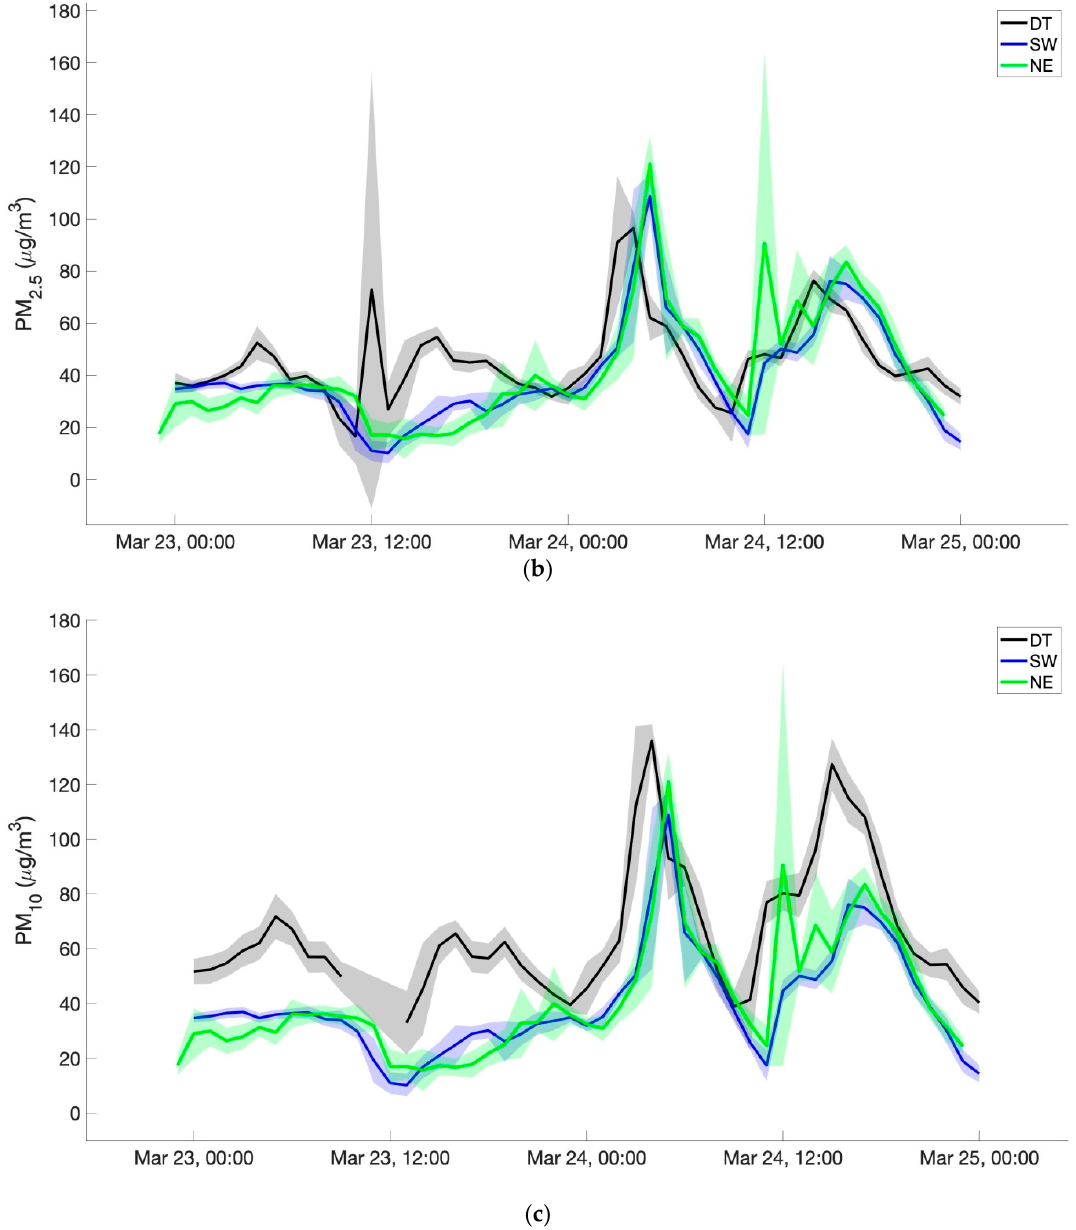
Figure 7. Air mass trajectory and PM concentrations in the three locations during 23–25 March period ( a ) NOAA-HYSPLIT model results (GDAS—top, GFSG—middle, and CDC1—bottom). The colored lines represent the following arrival times: yellow—23 March at 12:00, magenta—23 March at 18:00, sky blue—24 March at 00:00, green—24 March at 06:00, blue—24 March at 12:00, and red—24 March at 18:00. The marks on the lines represent six-hour steps; ( b ) hourly PM 2.5 ; ( c ) hourly PM 10 .